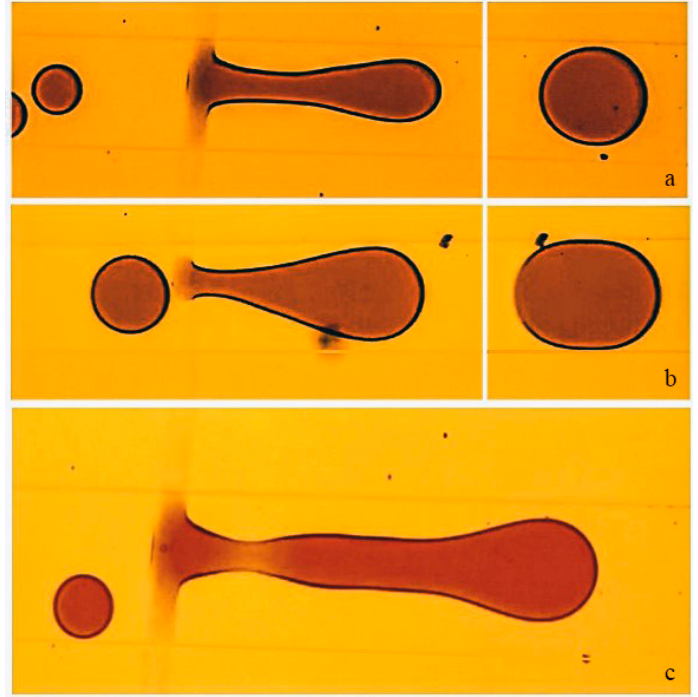
Figure 5. Coalescence and detachment process of merged droplet from the GO patterned COC surface. ( a ) Merging of six droplets with initial diameter of 86 µm, the flow rates were 300 µL/h for oil and 50 µL/h for water ( b ) Merging of three droplets with initial diameter of 138 µm, the flow rates were 250 µL/h for oil and 50 µL/h for water ( c ) Neck development before the detachment of the merged droplet. The dimension of the channel (W × H) is 200 µm × 50 µm. The width of the GO pattern is approximately 30 µm and is patterned along the width of the channel.